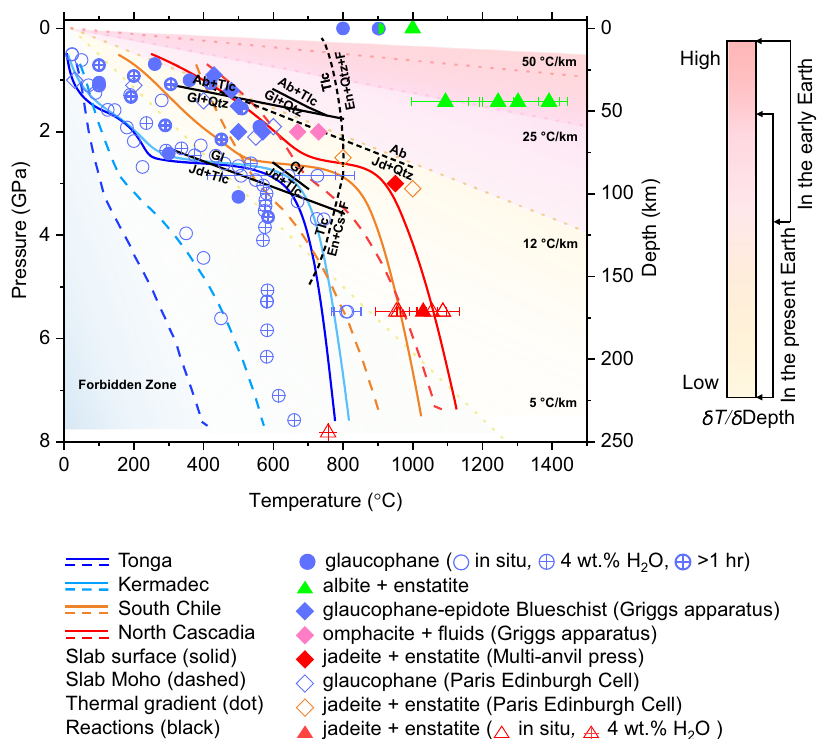
Fig. 1 Stability of glaucophane at P – T conditions of different subduction geotherms. Curved lines represent individual subduction geotherms from Syracuse et al. 19 . Continuous and dashed curves denote the P – T paths of subducting slab surfaces and corresponding slab Moho, respectively. The Tonga and Kermadec represent cold subducting slab, whereas the North Cascadia and South Chile represent warm subducting slabs. Black lines represent the upper- and lower-pressure stability of glaucophane from previous studies 33,34,39 , while black dashed lines represent related reactions 40,61 – 63 . The colored trilateral regions from top to bottom represent high, intermediate, and low geothermal gradients ( δ T / δ Depth), as de fi ned by Brown and Johnson 3 . The forbidden zone is a P – T region of ultrahigh pressures, where many numerical models predict slab-top geotherms of <5 °C km − 1 (ref. 64 ). High-temperature experiments at ambient pressure were performed as a reference (Supplementary Fig. 9). Phase abbreviations: glaucophane (Gl), jadeite (Jd), enstatite (En), albite (Ab), talc (Tlc), quartz (Qtz), coesite (Cs), and fl uid (F).